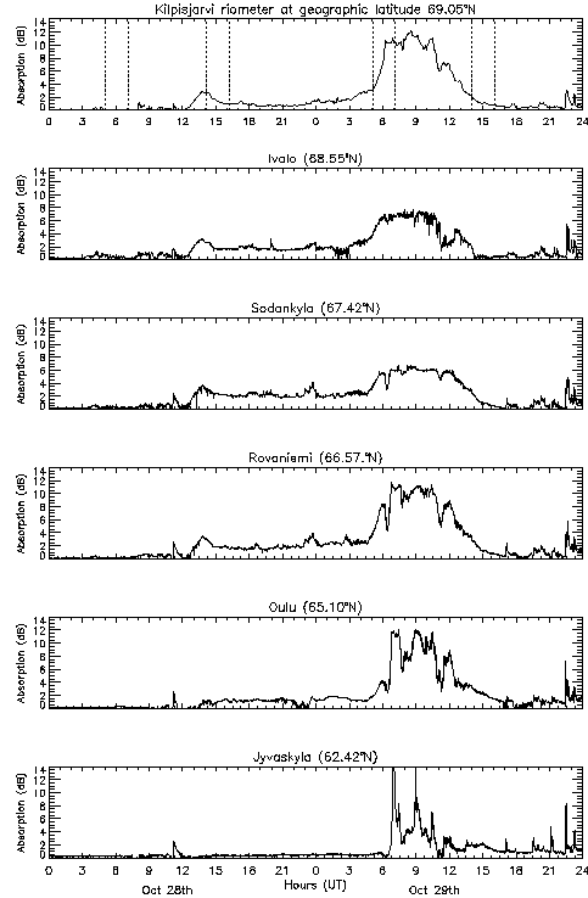
Fig. 3. Cosmic-noise absorption observed by riometers in Scan- dinavia, 28–29 October 2003, covering invariant latitudes 65 · 7, 64 · 8, 63 · 7, 62 · 8, 61 · 2, and 58.7 ◦ , respectively. The riometers at Rovaniemi and Jyvaskyl¨a operate at 32 · 4MHz, Kilpisj¨arvi at 38 · 2MHz, and the others at 30 · 0MHz. The vertical dotted lines show morning and evening